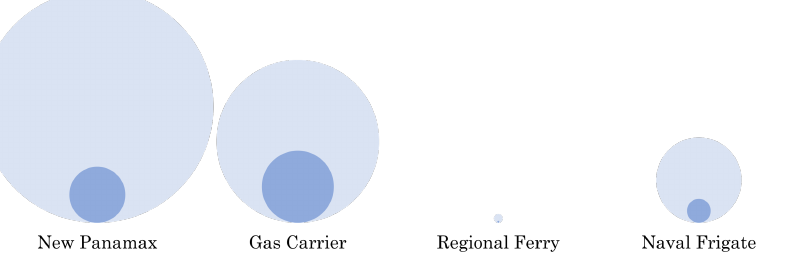
Figure 15. A scale comparison of the original and adjusted range of the vessels after adopting ammonia-fuelled